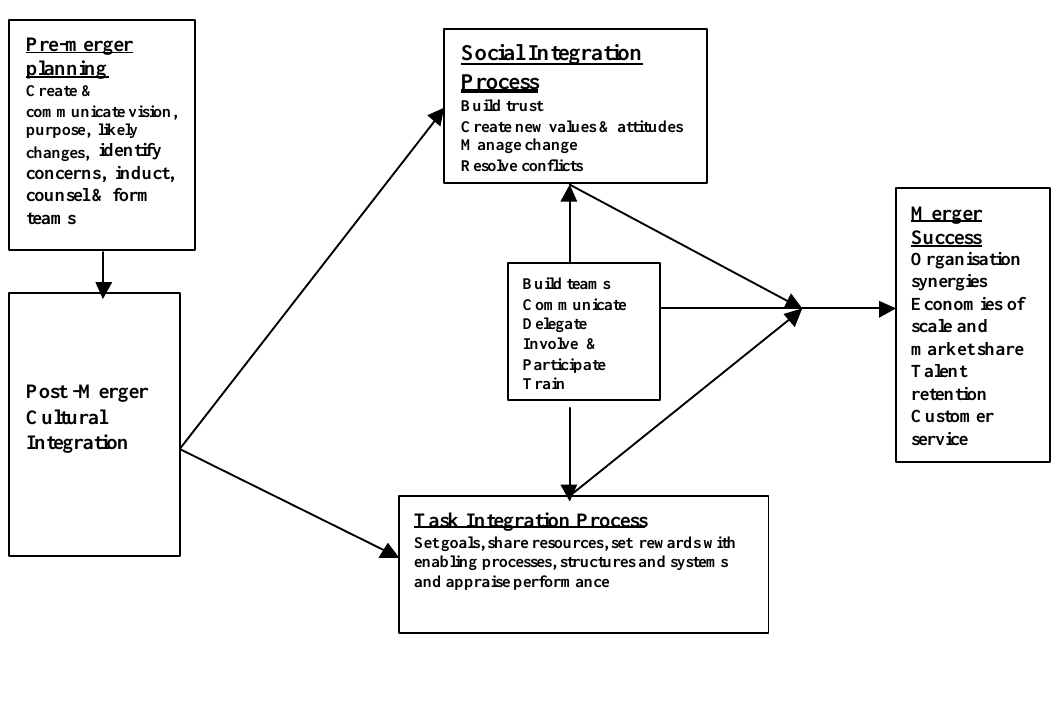
Figure 1: A framework for managing HR and cultural integration before and after a merger An aim of this study was to determine common themes in M&A’s and the literature. Insights and lessons gleaned are presented to assist managers in future endeavours in this area. Mergers and acquisitions are increasing globally. With the changing diversity of labour markets, diversity within organisational cultures, is